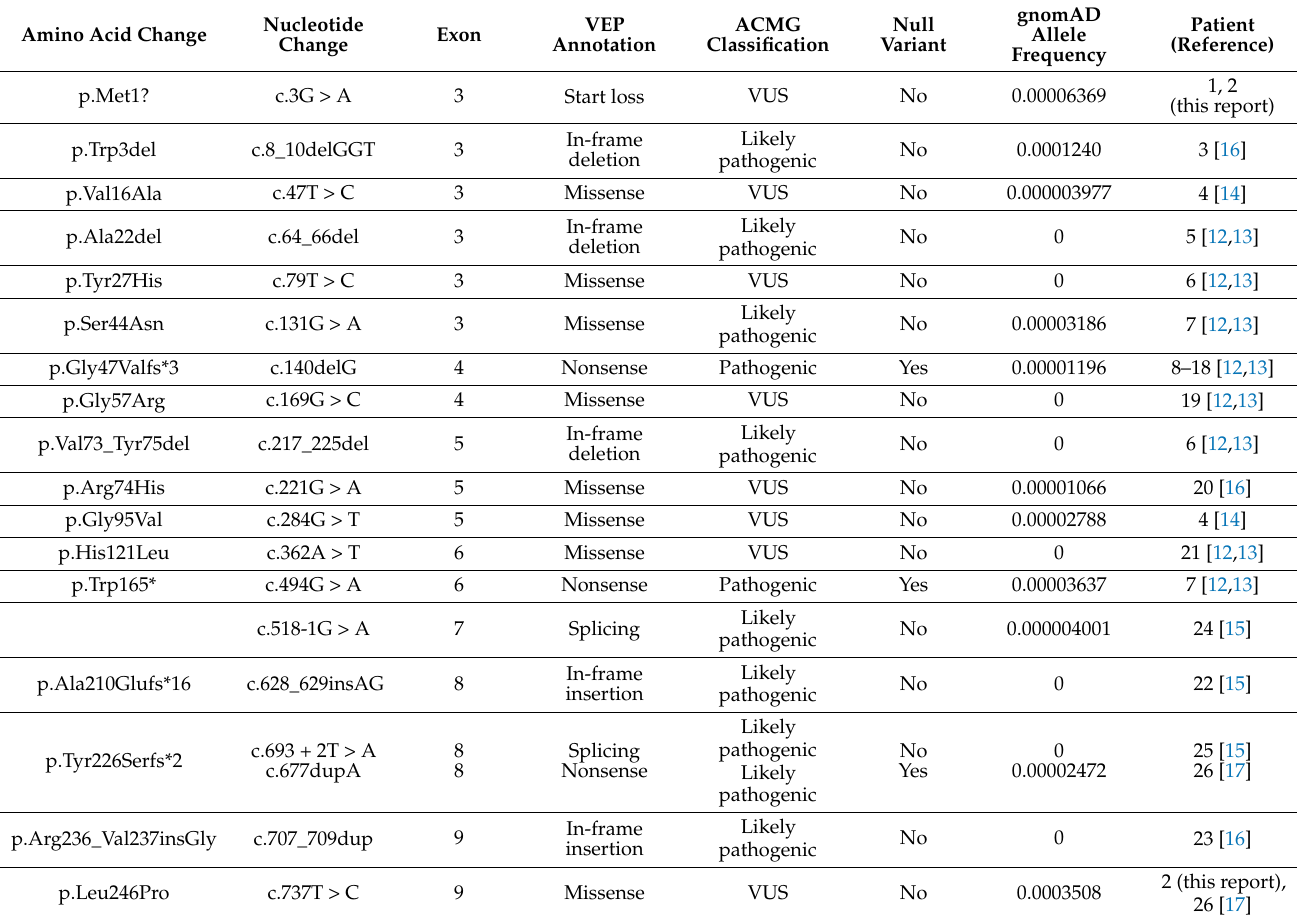
Table 2. Pathogenic variants in DRAM2 associated with retinopathy from our study (Patient 1 and Patient 2) and previously published cases